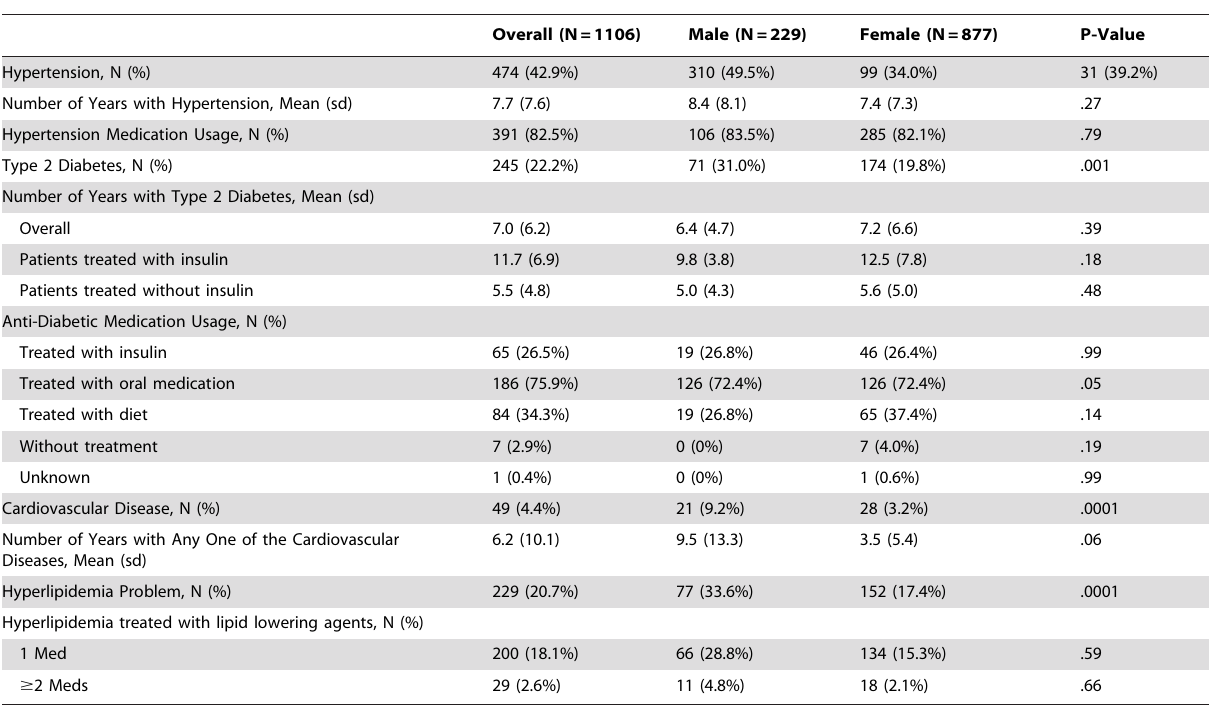
Table 4. Baseline Comorbidities by Gender.